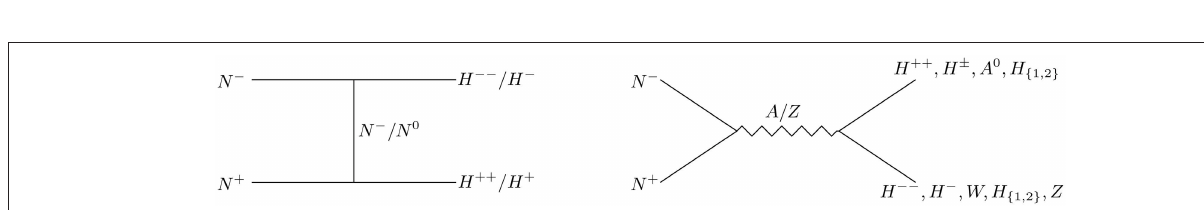
FIGURE 9 | Co-annihilation channels of ILD DM ( N 0 ), with charged fermions N − in presence of scalar triplet.